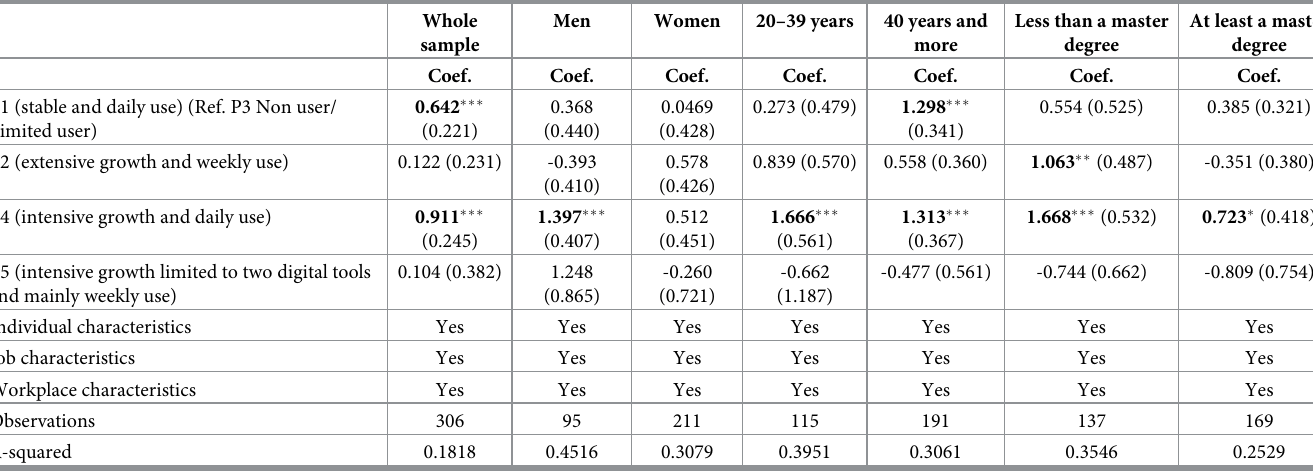
Table 5. Collaborative and communication digital profiles and the evolution of job stress before and during the lockdown by sub-samples (ordered probit model).